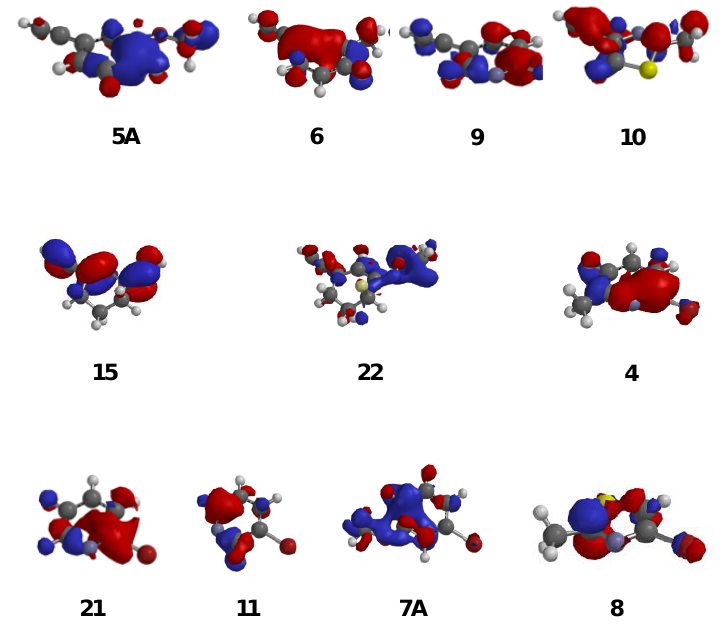
Figure 4. HOMO diagrams for all computationally investigated molecules (alkynes and halides) calculated using DFT method within the Spartan Molecular Modeling kit.